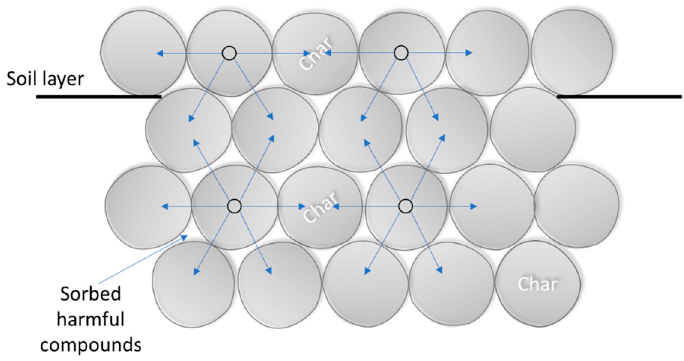
Figure 3. Surface absorption layer model.